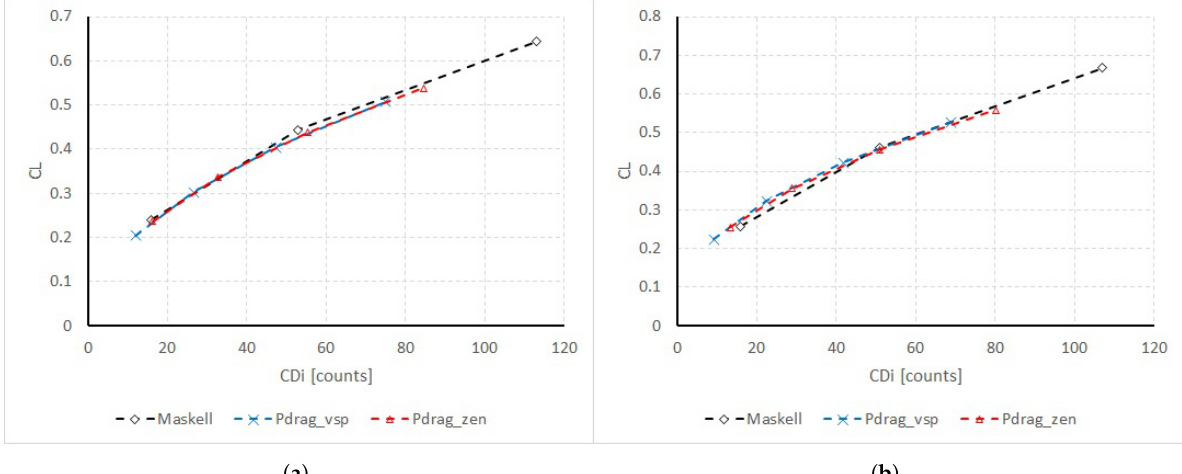
Figure 24. Wing-induced drag computed by different methods, in cruise flight: ( a ) power-off; ( b ) IB- OB-1 power